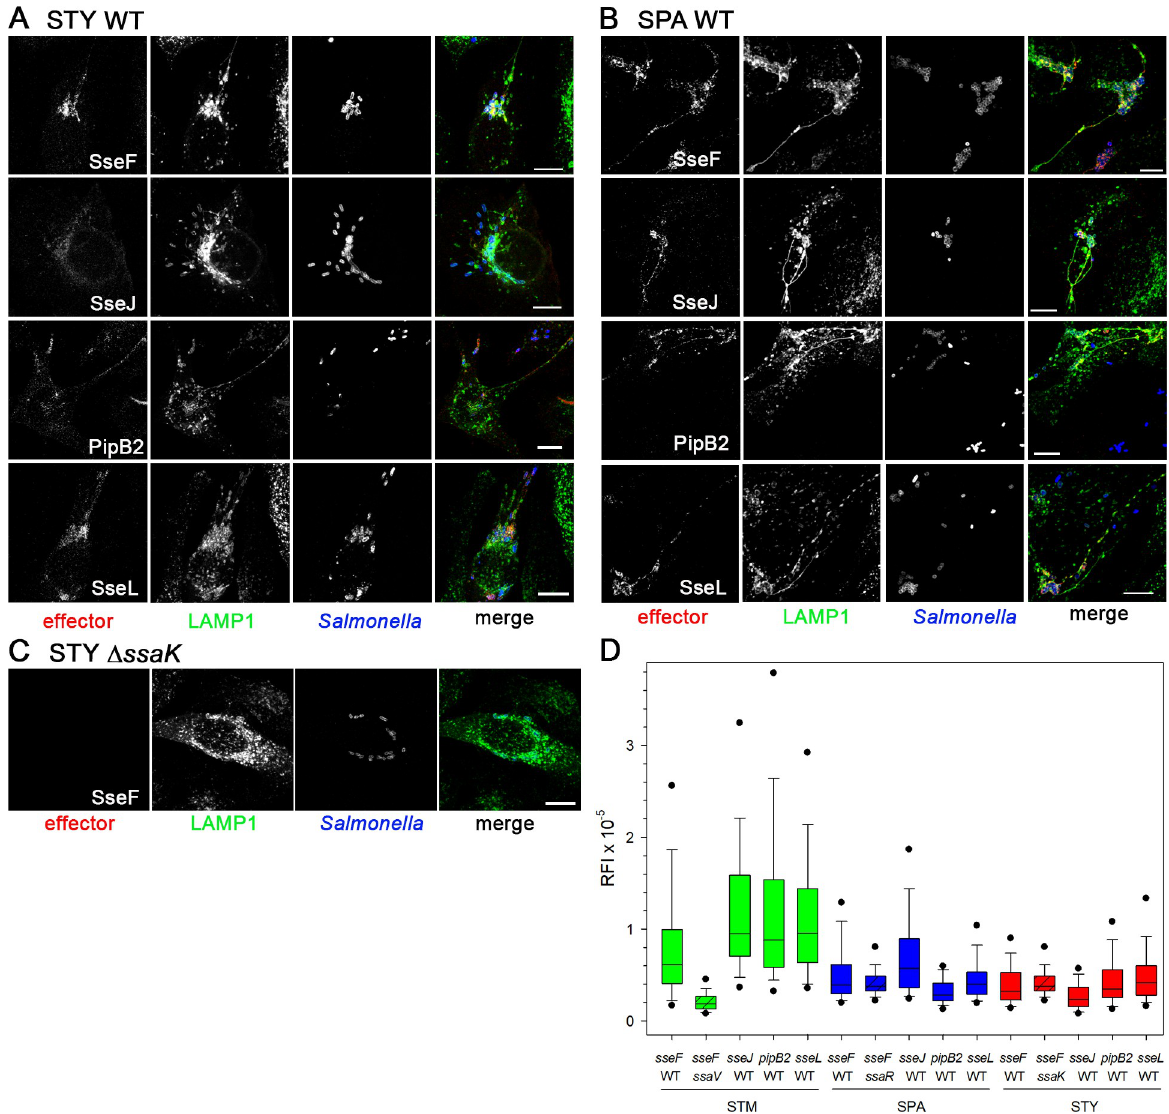
Fig 3. The SPI2-T3SS of SPA and STY is functional in translocation of effector proteins. HeLa cells constitutively expressing LAMP1-GFP (green) were infected with STY WT ( A ) or SPA WT ( B ) harboring plasmids for expression of sseF ::M45, sseJ ::M45, pipB2 ::M45, or sseL ::HA as indicated. At 9 h p.i., cells were fixed, permeabilized by Saponin and immunolabeled for M45 or HA epitope tags (red) to localize translocated effector proteins, and with serovar-specific anti O-Ag antibodies to label bacteria (blue). C ) Micrographs of cells infected with SPI2-T3SS-defcient STY strain Δ ssaK harboring a plasmid for expression of sseF ::M45. Microscopy was performed by CLSM using a Leica SP5 with 100x objective. Scale bars: 10 μ m. D) Quantification of SPI2-T3SS effector protein translocation by intracellular STM, STY or SPA. HeLa cells were infected as for A )- C ) with STM, STY, or SPA WT strains all harboring plasmids encoding epitope-tagged effector proteins sseF , sseJ , pipB2 , or sseL , or SPI2-T3SS-deficient strains STM Δ ssaV , STY Δ ssaK , SPA Δ ssaR harboring a plasmid encoding sseF ::M45. Cells were fixed 8 h p.i., permeabilized, and immunostaining of Salmonella LPS and epitope tags of translocated effector proteins was performed. Cells harboring Salmonella were randomly selected, and for at least 100 infected cells for each condition, fluorescence signals of translocated effector were measured within ROIs defined by the host cell perimeters and expressed as relative fluorescence intensities (RFI). Boxes define 25th and 75th percentiles. Outlyers in the 5 th and 95 th percentiles are indicated by dots. Medians and standard deviations are indicated by lines in boxes and whiskers, respectively.